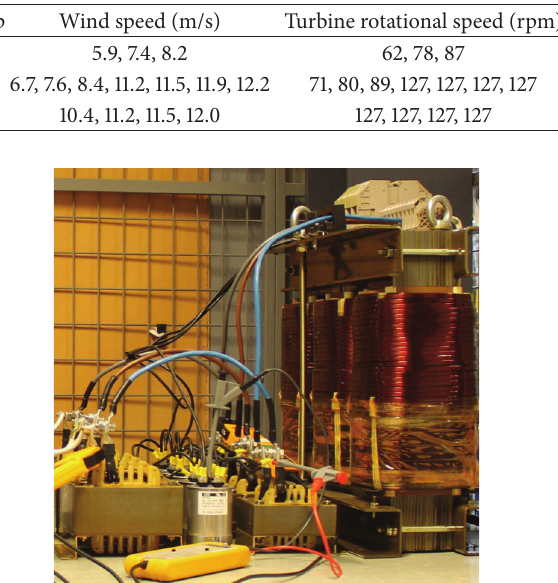
Figure 6: LCL filter to the left and tap transformer to the